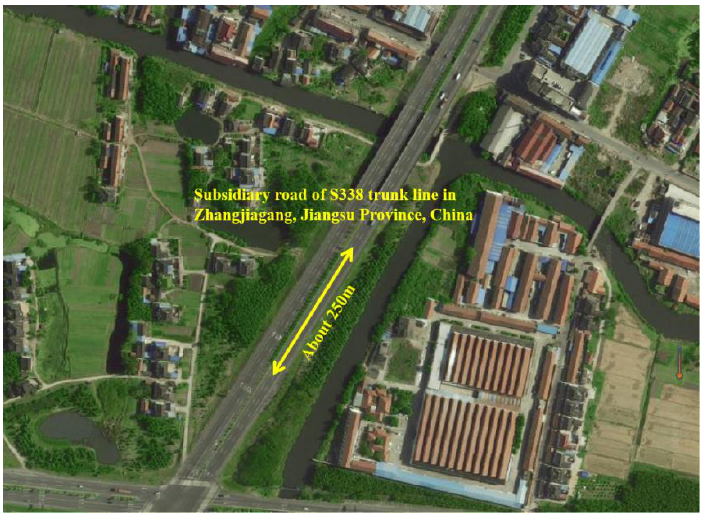
Figure 11. Position of test section.